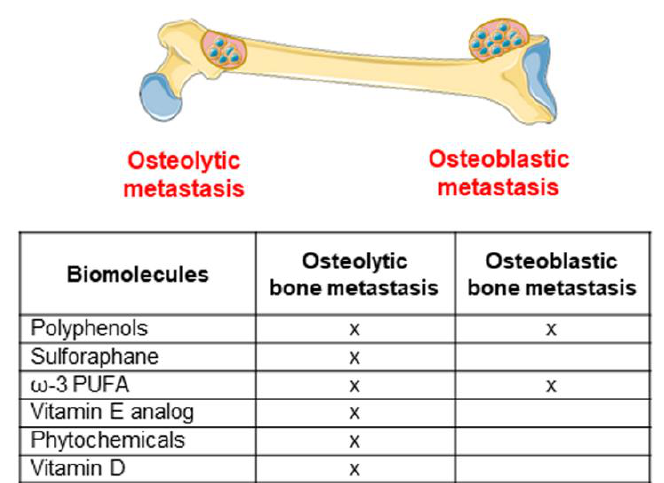
Figure 2. Dietary compounds involved in the inhibition of osteolytic and osteoblastic metastasis development (figure created using Servier Medical Art available at https://smart.servier.com, accessed on 10 June 2021). “X” indicates the involvement in the processes.